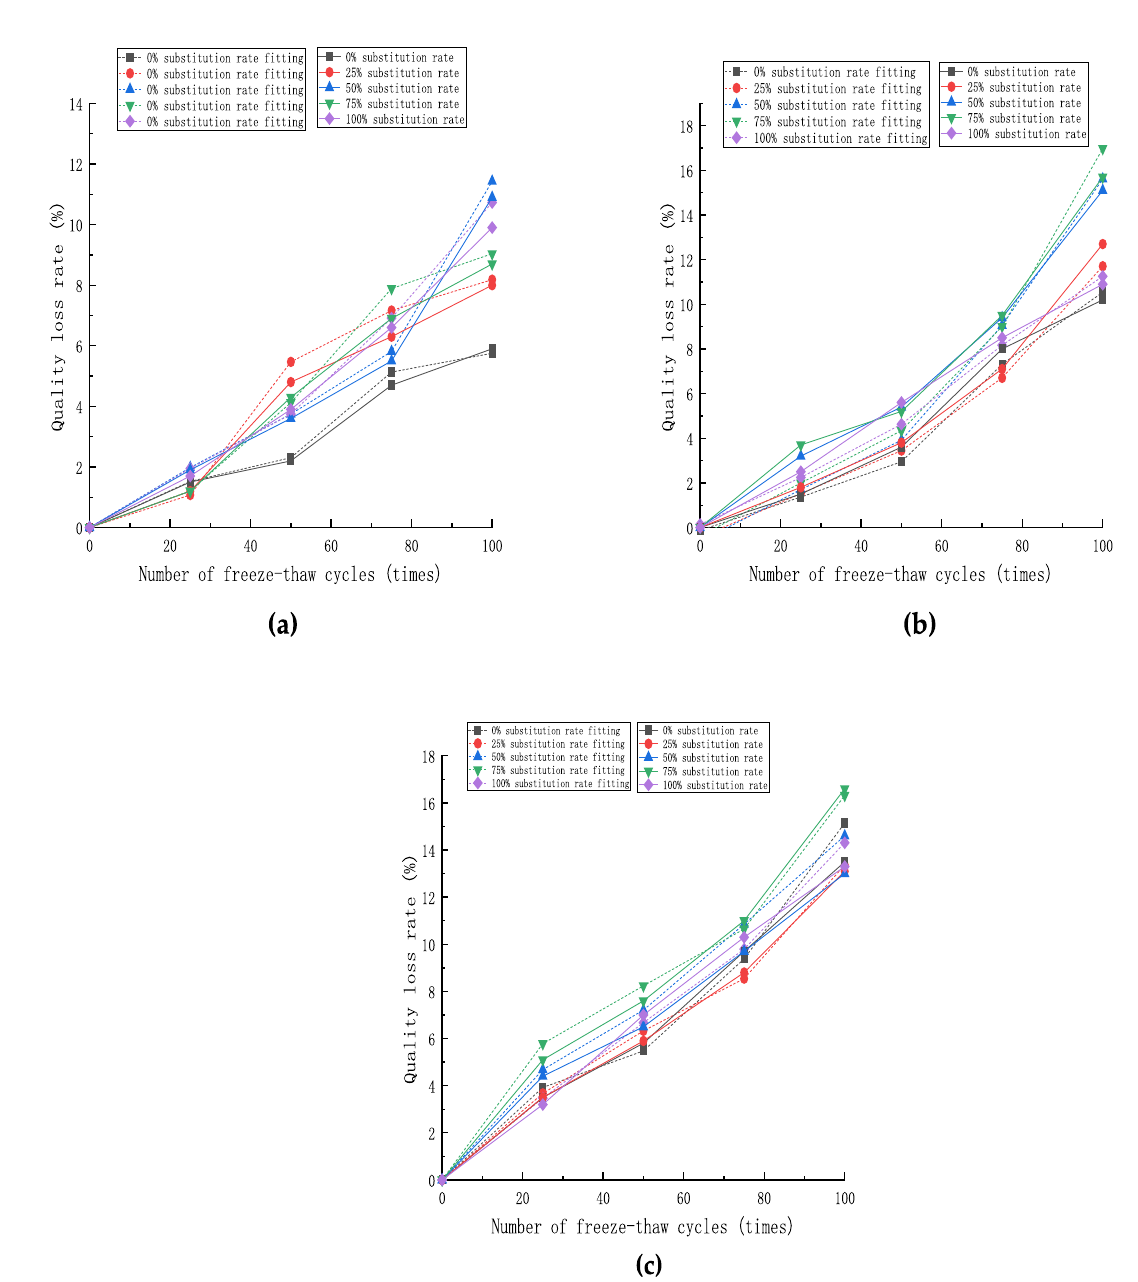
Figure 12. Mass loss rate fitting curve: ( a ) steel fiber content 0%; ( b ) steel fiber content 1%; ( c ) steel fiber content